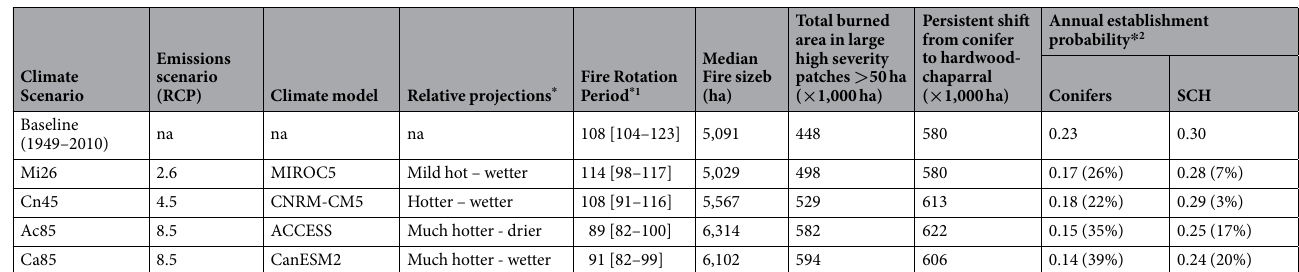
Table 1. Baseline and climate change scenario projections. Relative projections are a qualitative description of Fig. S1 offered here to assist with synthesis. These categories are based on average annual statistics over the course of the simulation (85 years) for mean annual temperature and annual precipitation. Annual probability of establishment shifts across species in conifer and shrubland-chaparral-hardwood (SCH) species under different climatic conditions. These values are averages across species and time. * See Fig. S1 for quantitative values. * 1 Range in brackets indicates 25 th –75 th percentile. * 2 Percentages in parenthesis indicate the percentage of probability of establishment loss with respect to baseline